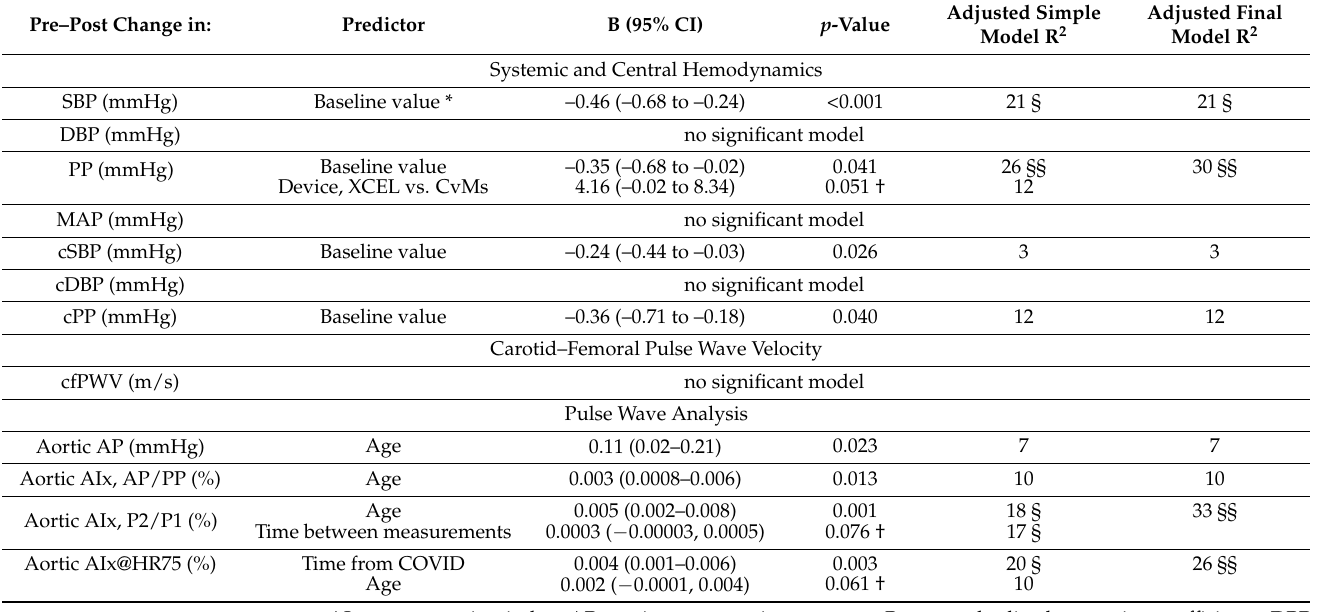
Table 3. The predictors of the pre–post COVID-19 changes in systemic and central hemodynamic parameters and arterial stiffness parameters, as estimated by the linear regression models.